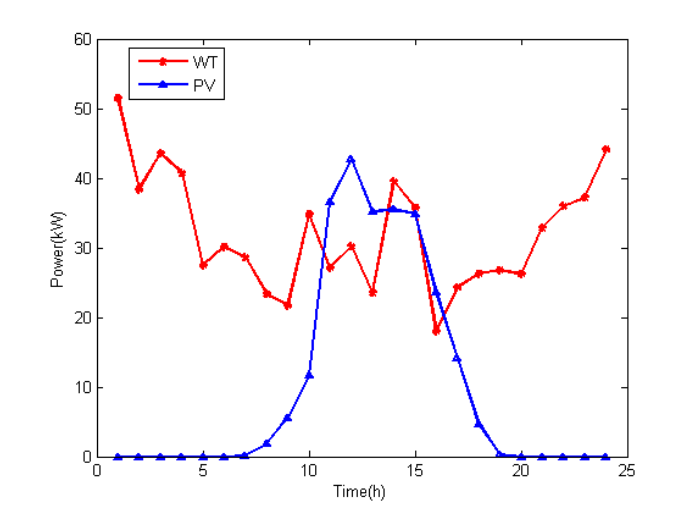
Figure 2. Forecast values of wind and photovoltaic power.